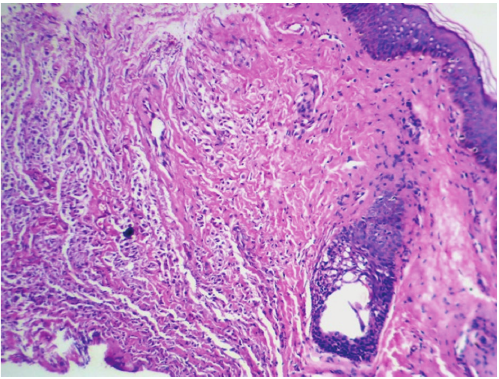
Figure 3: Toluidine blue stain. Mast cells with purple metachro- matic granules in the cytoplasm.